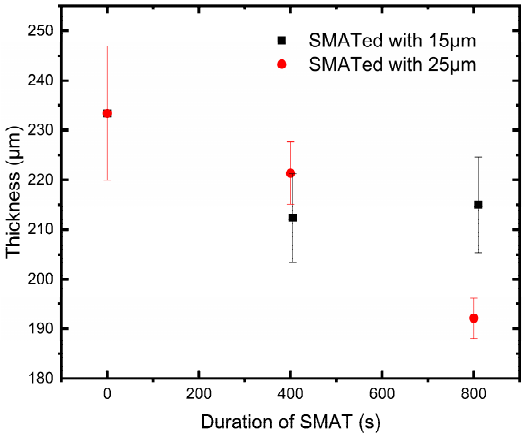
Figure 3. Coating thickness as a function of SMAT duration and amplitude.